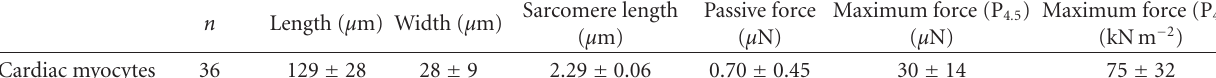
Table 1: Porcine cardiac myocyte preparation characteristics.